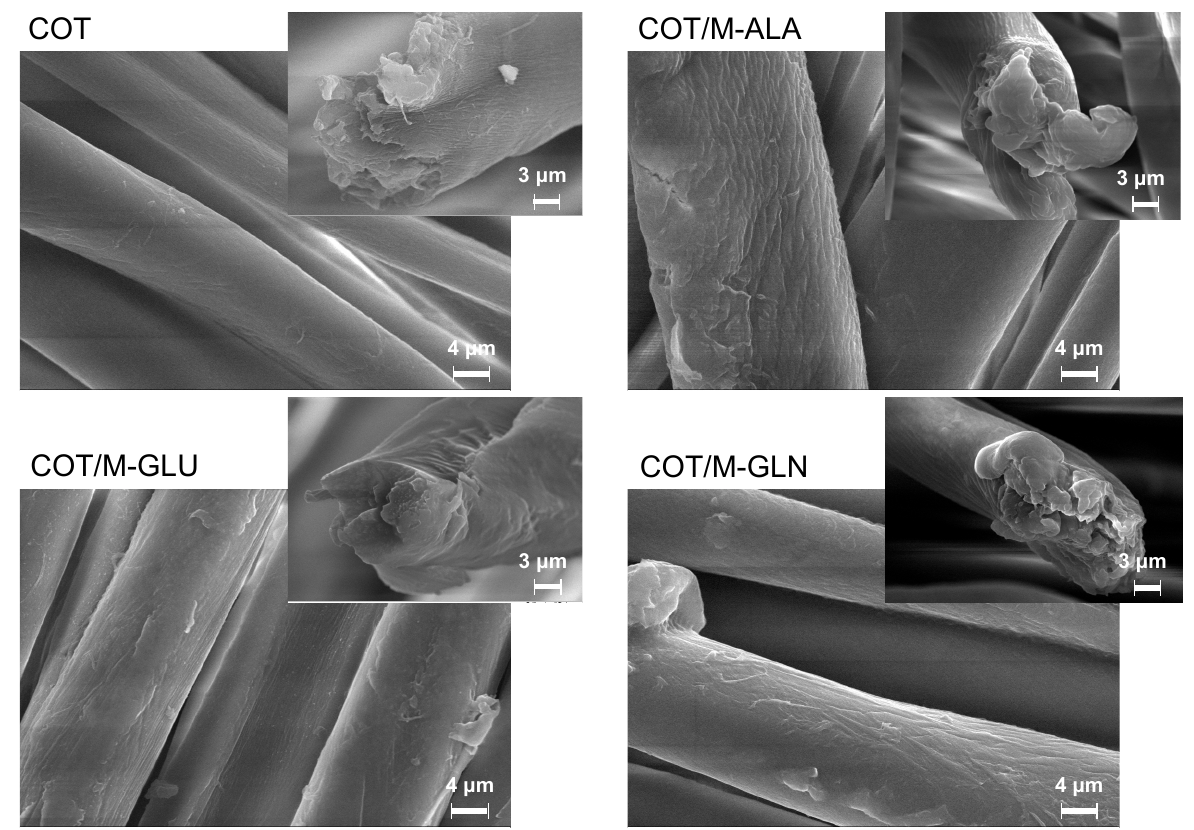
Figure 4. SEM micrographs (5000×) of untreated cotton (COT) and cotton fabrics treated with 7% add-on M-ALA, M-GLU and M-GLN. Insert magnification 10000×.